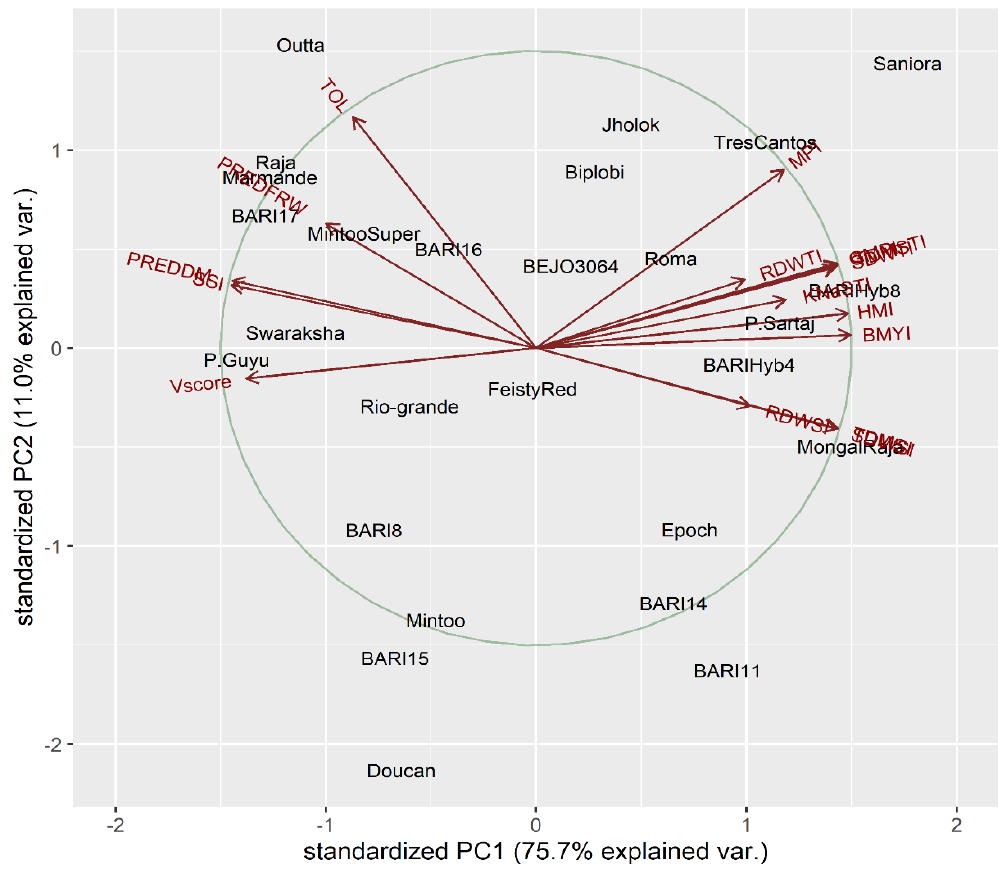
Figure 3. Principal component biplot for genotypes × salt tolerance index traits for 27 tomato genotypes at the early growth stage with non-salinized control (S1) with 18.2 mM NaCl and salinized (S2) with 200 mM NaCl conditions during 2018–2019 (VScore = visual salt damage score, TOL = tolerance index, SSI = stress susceptibility index, PREDFRW = percent reduction of fresh weight, PREDDM = percent reduction of dry weight, MPI = mean productivity index, HMI = harmonic mean index, GMPI = geometric mean productivity index, SDWSTI = shoot dry weight stress tolerance index, RDWSTI = root dry weight stress tolerance index, TDMSTI = total dry matter stress tolerance index, KNaSTI = potassium to sodium ion ration tolerance index, SDWSI = shoot dry weight salt tolerance index, RDWSI = root dry weight salt tolerance index, TDMSI = total dry matter salt tolerance index, and BMYI = biomass yield index).